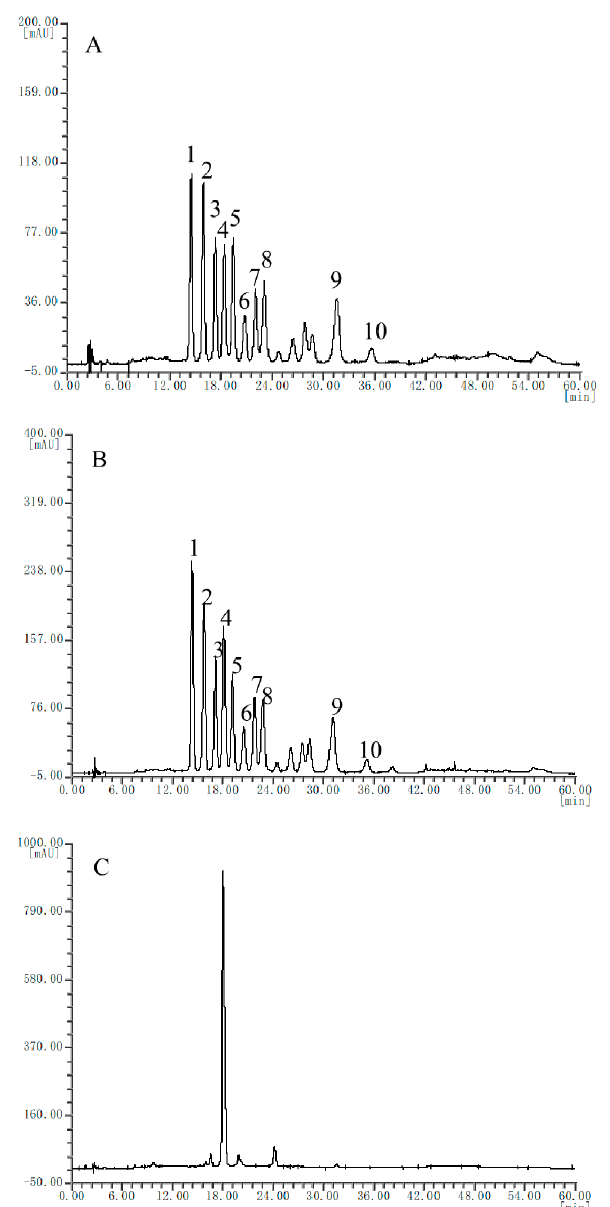
Figure 1. Representative HPLC (high-performance liquid chromatography) chromatograms of the reference extract ( A ), the bilberry extract samples ( B ), and bilberry extract sample A6 ( C ). Peak identification: 1, Delphinidin-3- O -galactoside (Del-3-gal); 2, Delphinidin-3- O